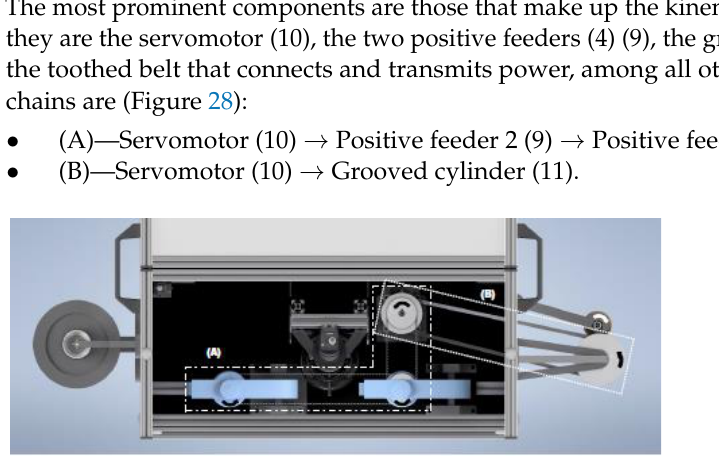
Figure 28. Kinematic chains (A and B are Servomotors) [32].